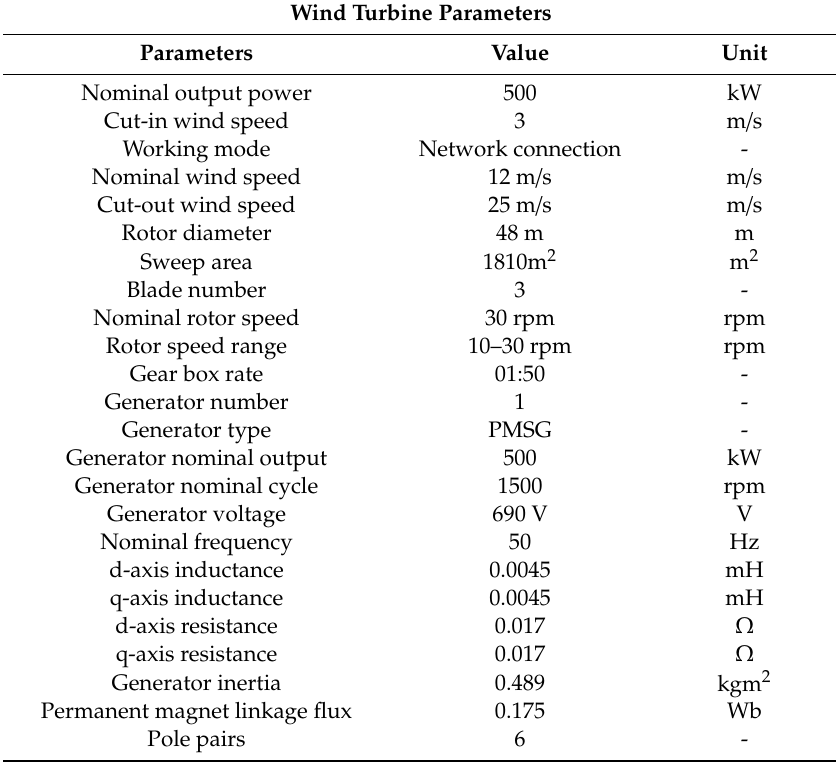
Table 1. Parameters of wind turbine system